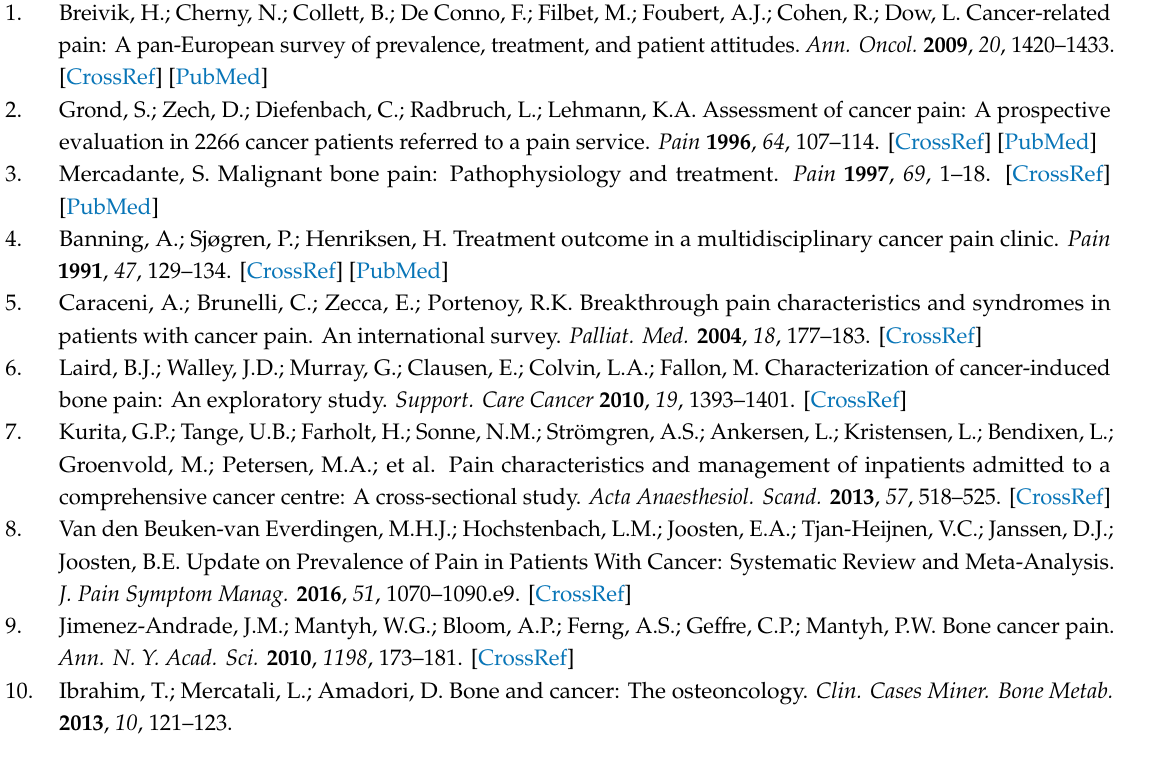
Figure S1: Development of nociception and osteolytic bone degradation in Sprague Dawley rats inoculated with Walker 256 or MRMT-1 cancer cells; Figure S2: Development of nociception and osteolytic bone degradation in male Sprague Dawley rats following Walker 256 cancer cell